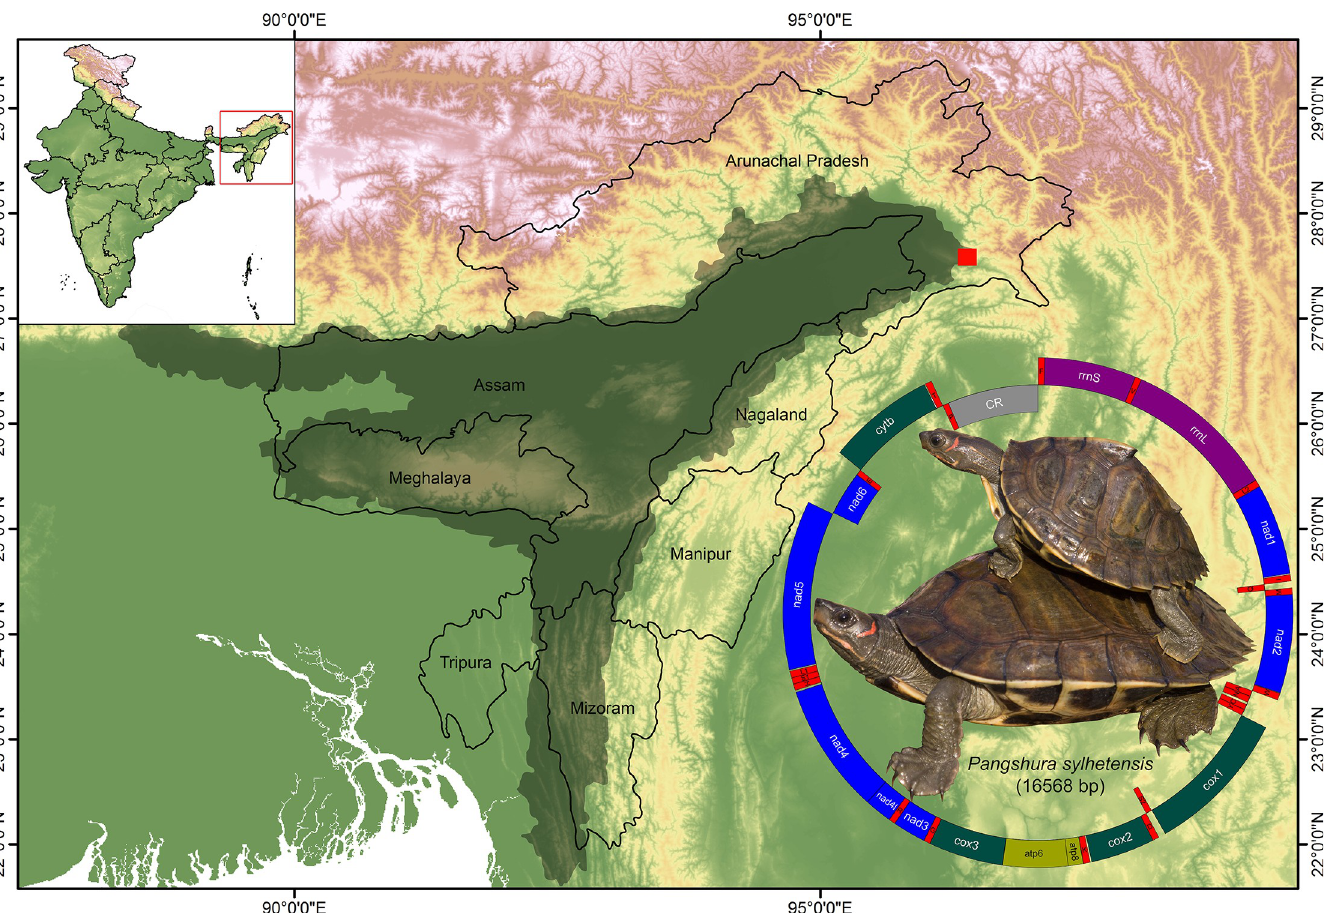
Fig 1. The spatial range distribution (marked by gray shadow) and collection locality (27.50 N 96.24 E marked by red square) of P . sylhetensis . The species photograph and mitochondrial genome of P . sylhetensis . Protein-coding genes are marked by blue, deep green, and yellowish-green color boxes, rRNA genes are marked by violet color boxes, tRNA genes are marked by red color boxes, and control region is marked by gray color box.